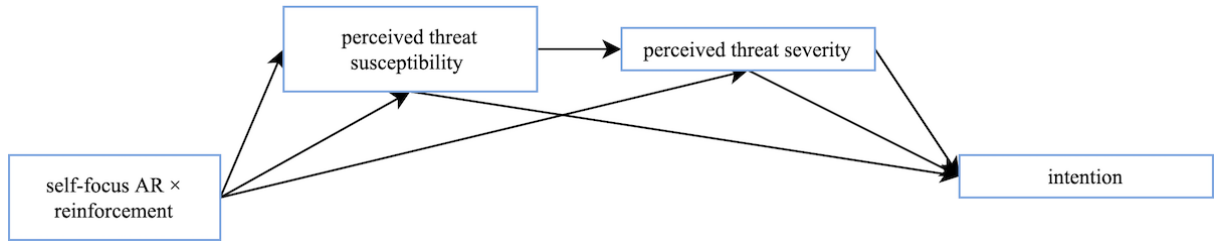
Figure 13. The self-focus augmented reality (AR) × reinforcement, susceptibility, severity, and intention mediation model. The self-focus AR × reinforcement condition resulted in an indirect effect on intention through threat susceptibility and threat severity. This condition also had an indirect effect on perceived threat severity through perceived threat susceptibility.